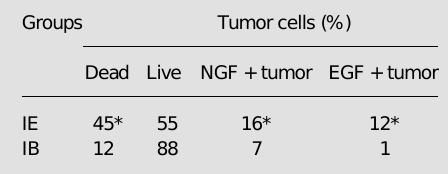
Table 1 - Effect of pre-incubation of Ehrlich tumor cells on tumor viability and growth factor staining after inoculation into mouse foot